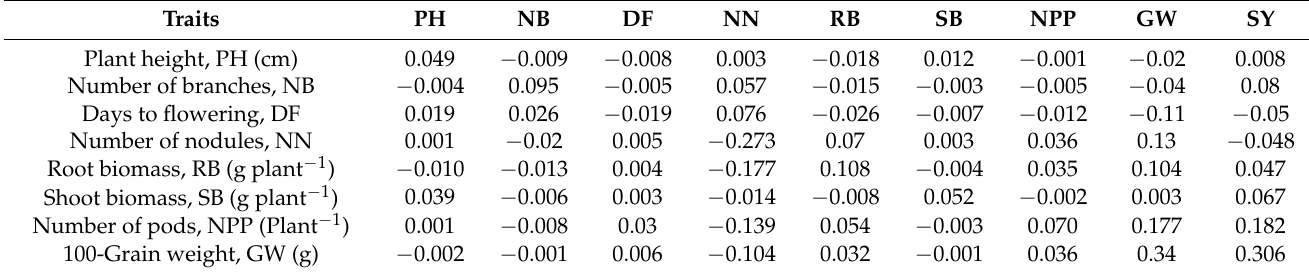
Table 6. Path analysis of direct and indirect effects of soybean traits on seed yield